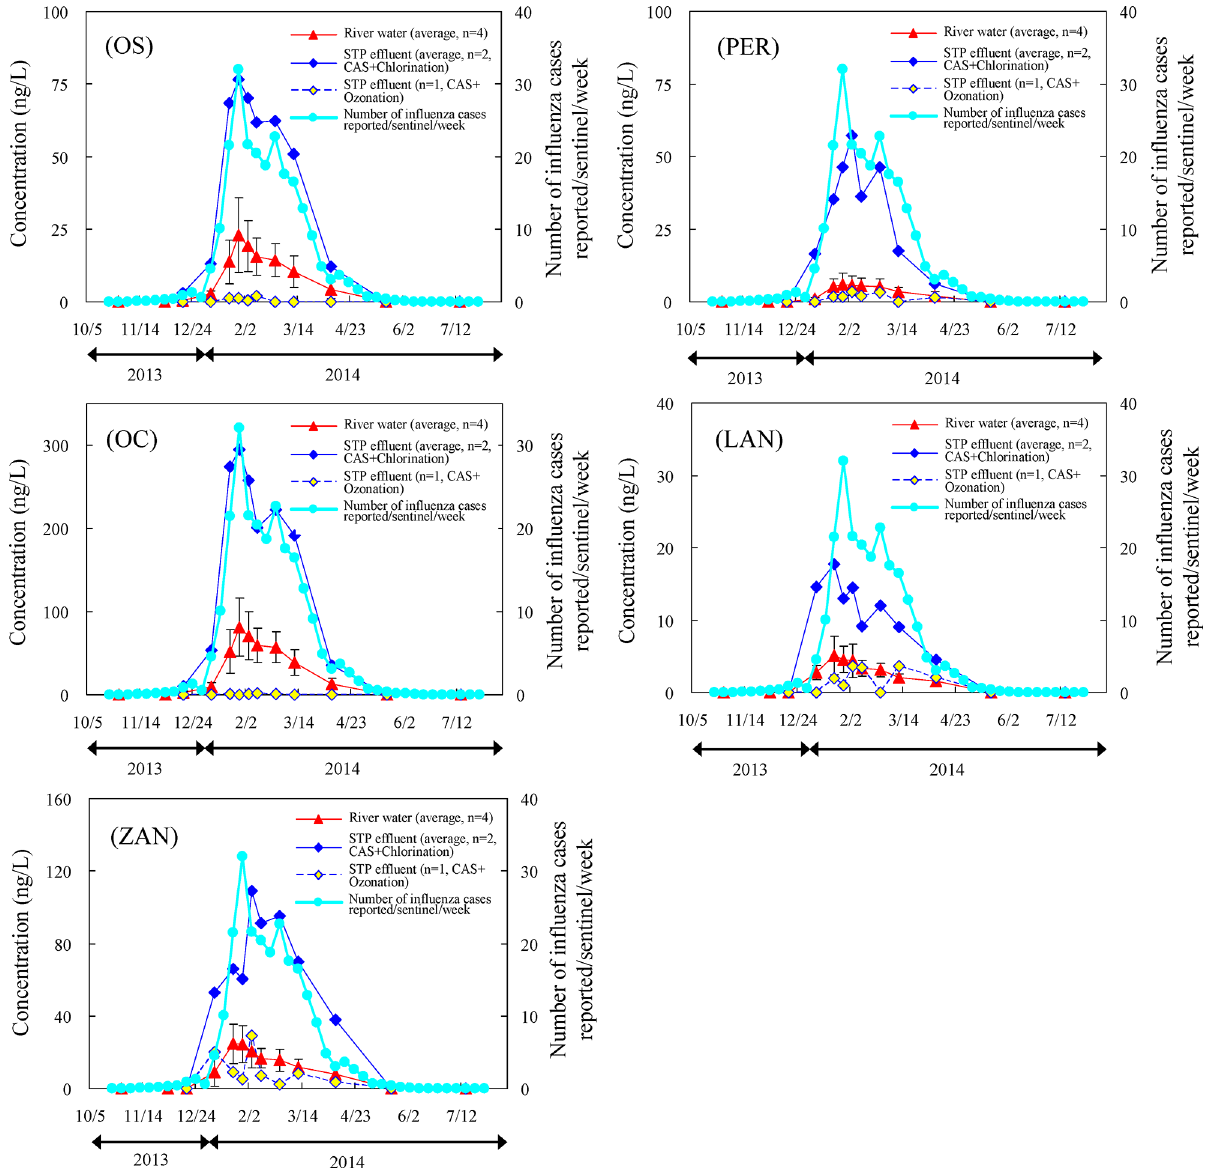
Fig 2. Time-dependent dynamics of OS, OC, ZAN, PER, and LAN average concentrations, with standard deviations, in river waters and STP effluent (CAS: conventional activated sludge systems) from July to June 2013 − 2014, including in the influenza outbreak season (January to March